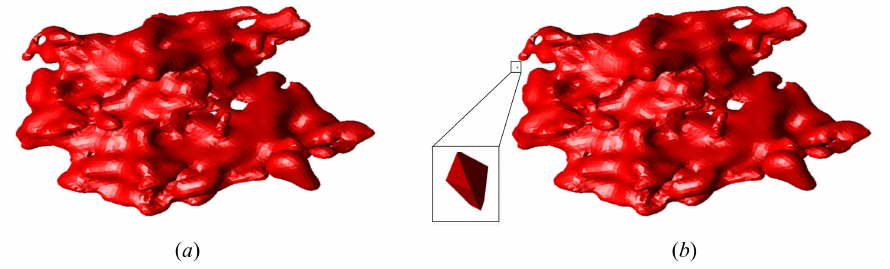
Figure 7. A reconstruction result when part of the model is smaller than the specified reconstruction size. ( a ) a failure reconstruction result; ( b ) a small object that do not be